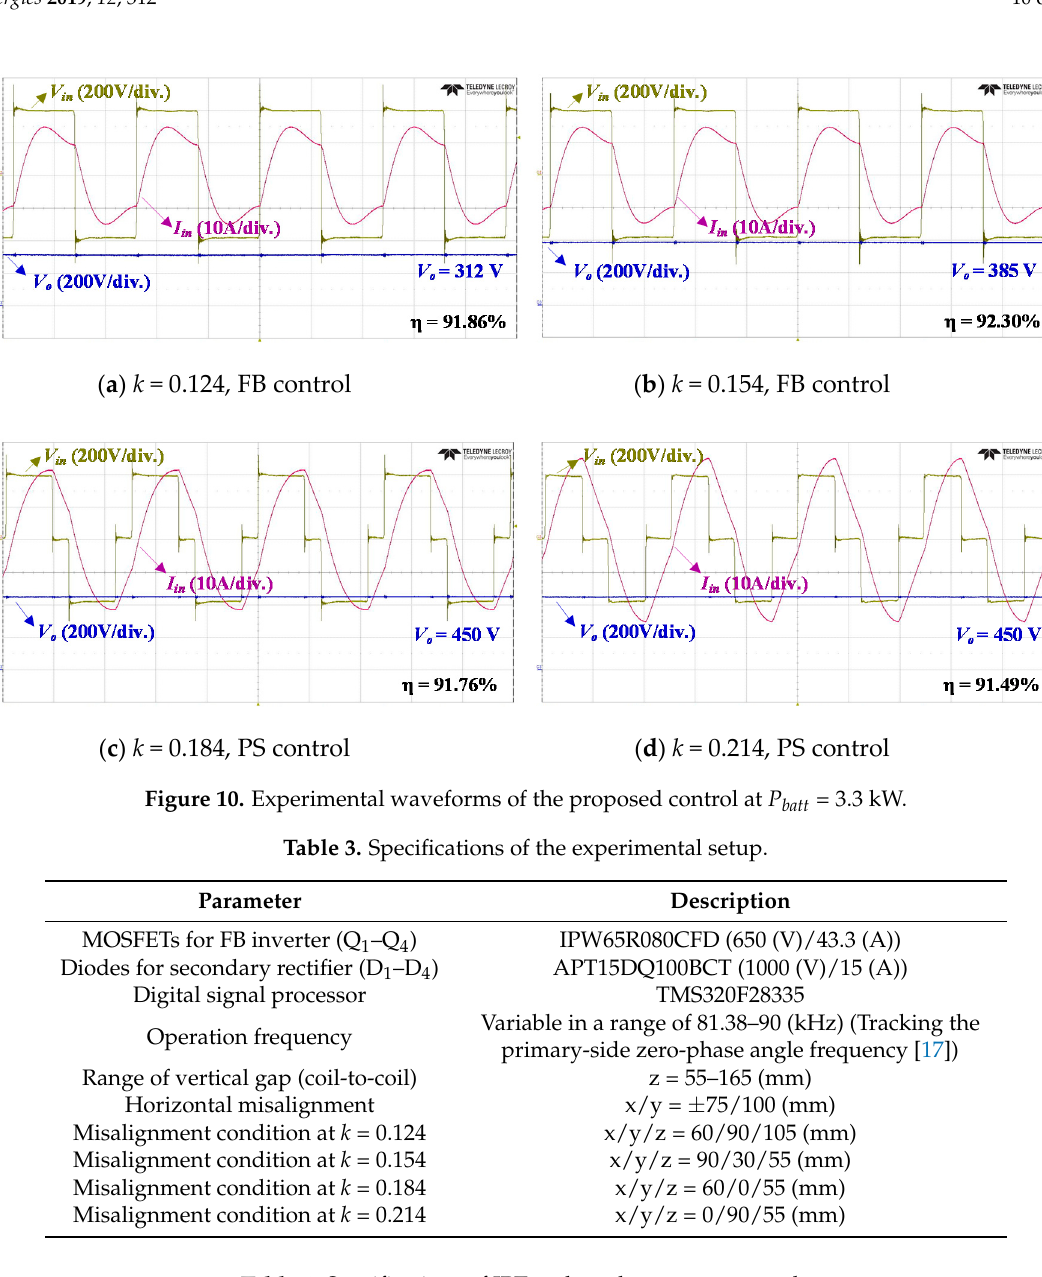
Table 4. Specifications of IPT pads and resonant